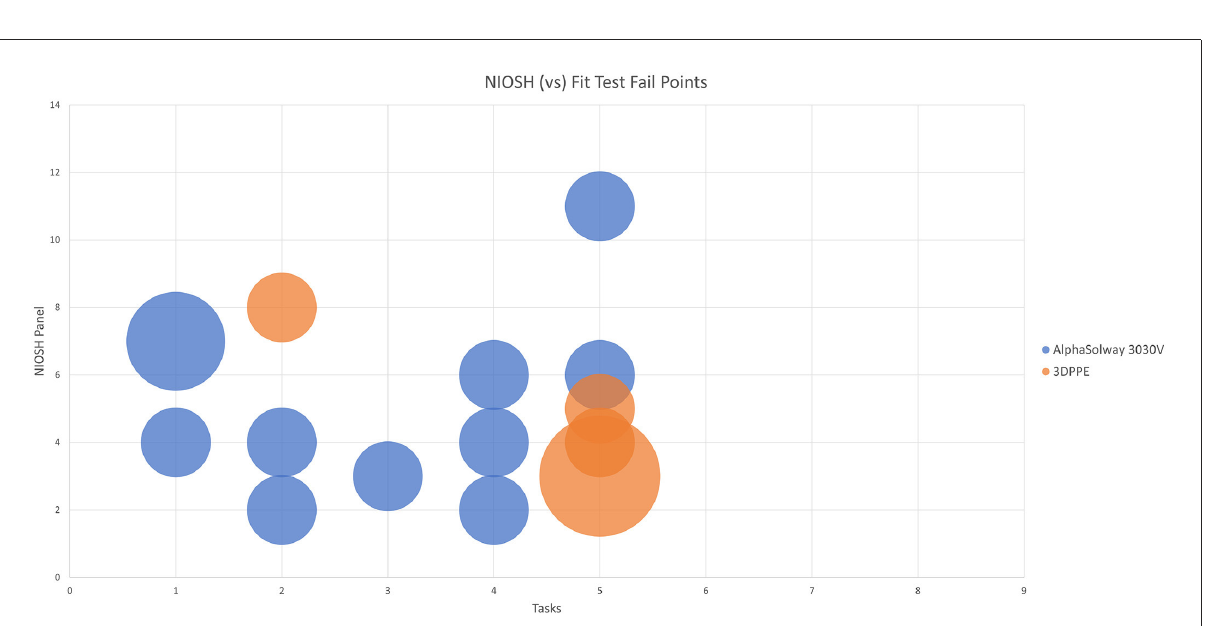
customized respirator was more comfortable than the control respirator in each of these subsections, with a significantly lower score ( p < 0.0001 for all comparisons; Figures 4B–D).